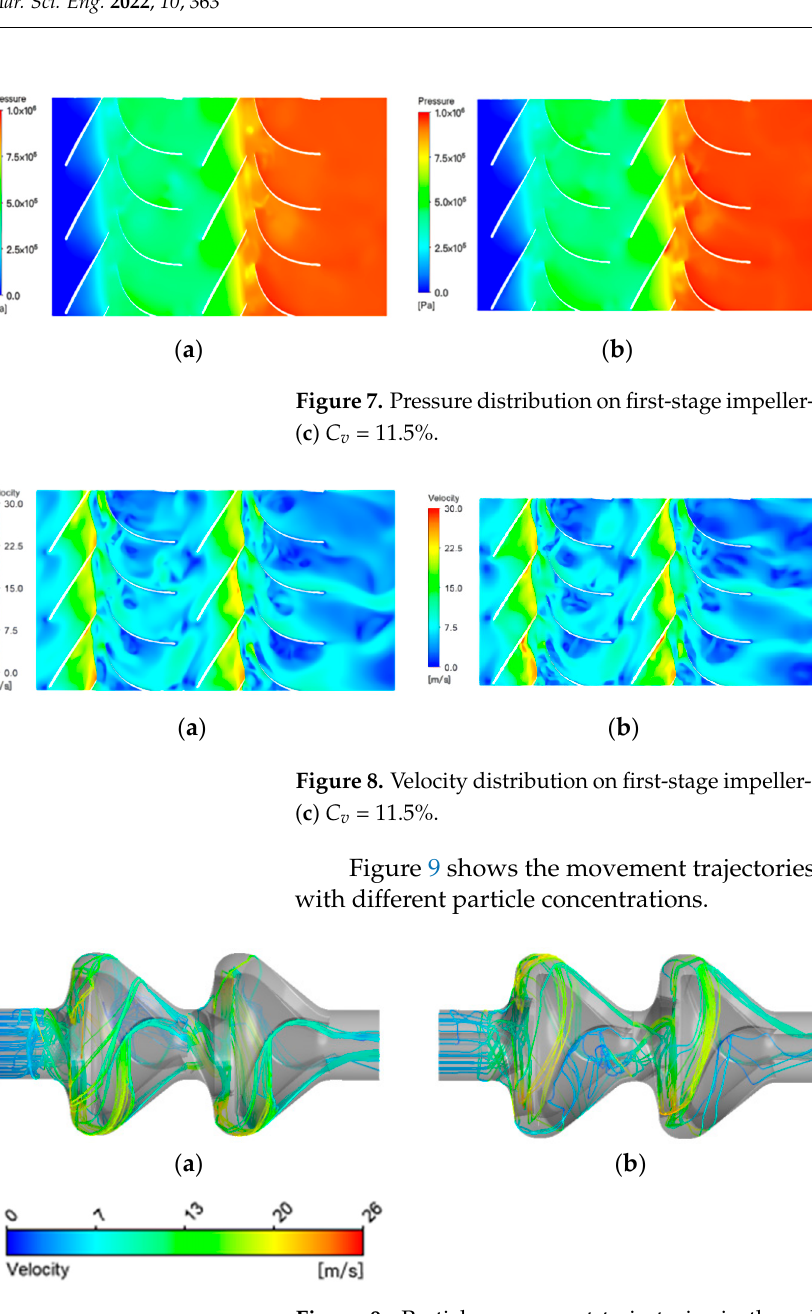
Figure 9. Particle movement trajectories in the calculation domain; ( a ) C v = 4%; ( b ) C v = 7.5%; ( c ) C v = 11.5%.